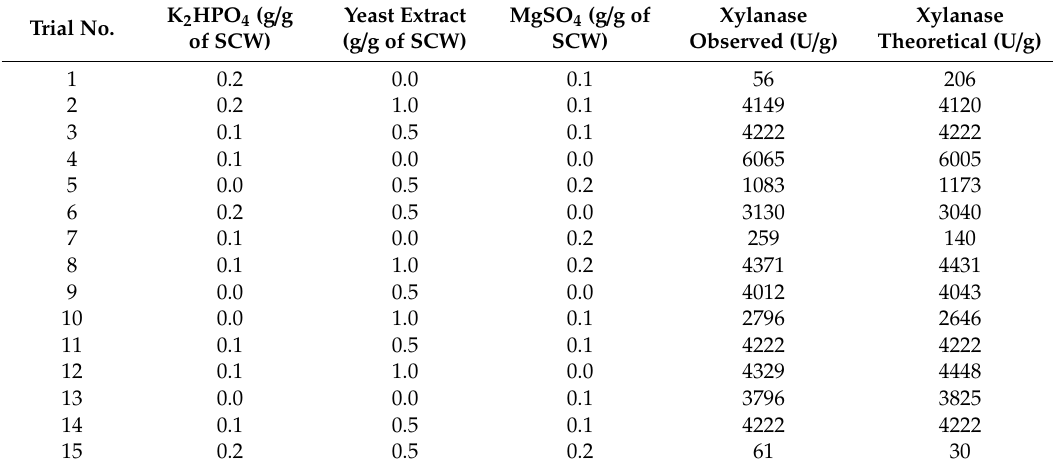
Table 7. Box–Behnken experimental design for SSF optimisation employing three independent variables, experimental, and predicted values for xylanase activity.